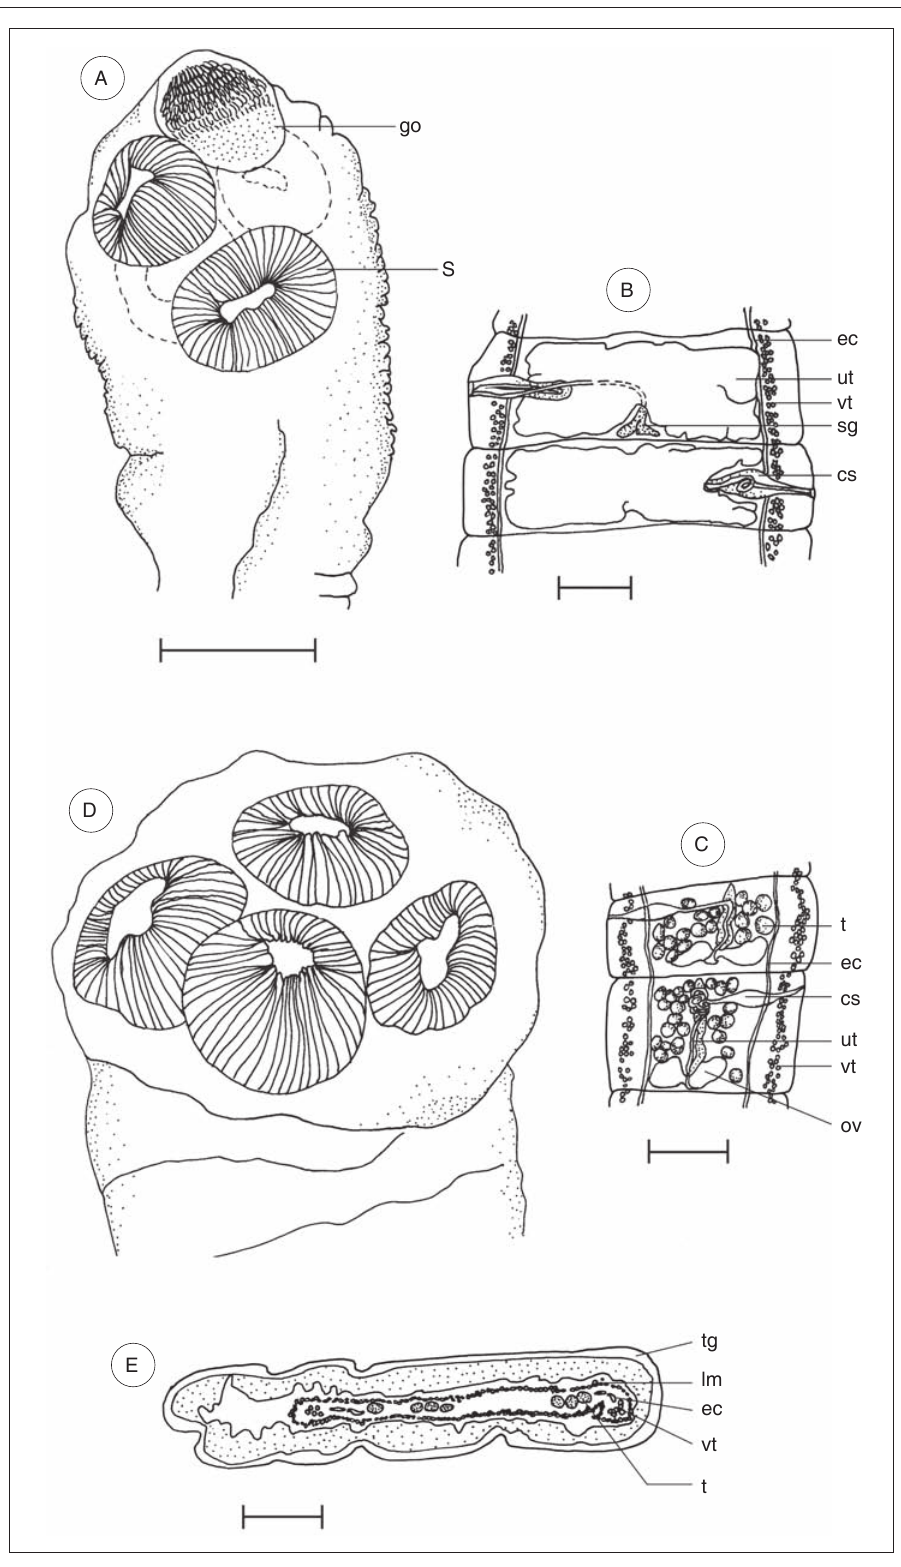
FIG. 3 Proteocephalus glanduliger (A, D) scolex (scale bar = 400 μ m), (B) gravid proglottid, (C) mature proglottid, (E) transverse section (scale bars = 200 μ m), ec = excretory canal, go = glandular organ, cs = cirrus sac, lm = longitudinal muscles, s = sucker, sg = shell gland, t = testis, tg = tegument, ut = uterus, vt